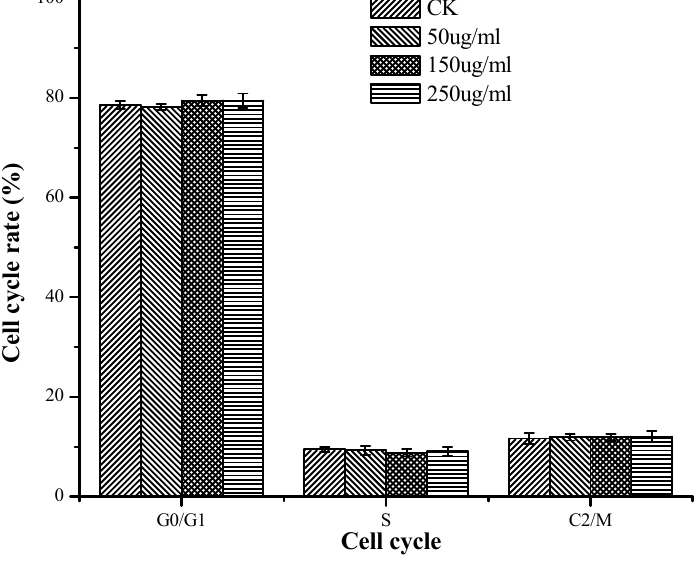
Figure 5. The cell cycle rate of cells treated with different concentrations of TSP.